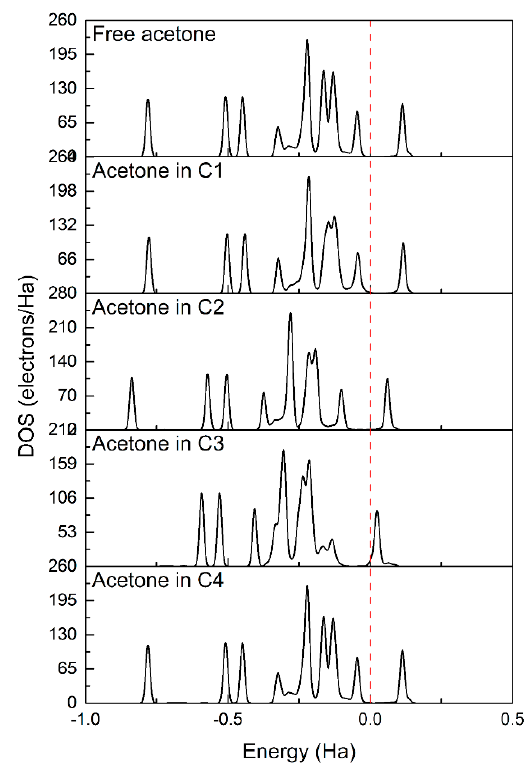
Figure 14. Total density of states (DOSs) of free acetone molecule and the adsorbed acetone in C1, C2, C3, and C4 mode. The vertical dotted line indicates the Fermi energy level.